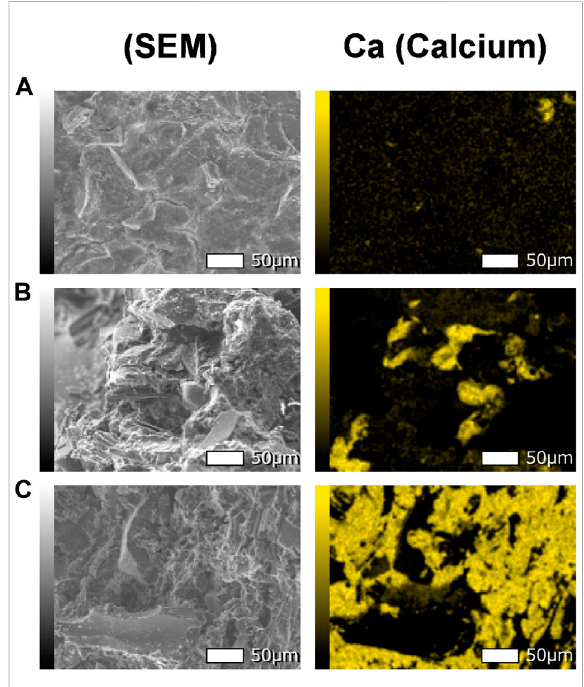
FIGURE 12 The SEM-EDS spectrum highlights (for Ca) for (A) untreated silty sand (Watsu), (B) B-EICP treated silty sand (Watsu) at 25 ° C and (C) B-EICP treated silty sand (Watsu) at 15 °